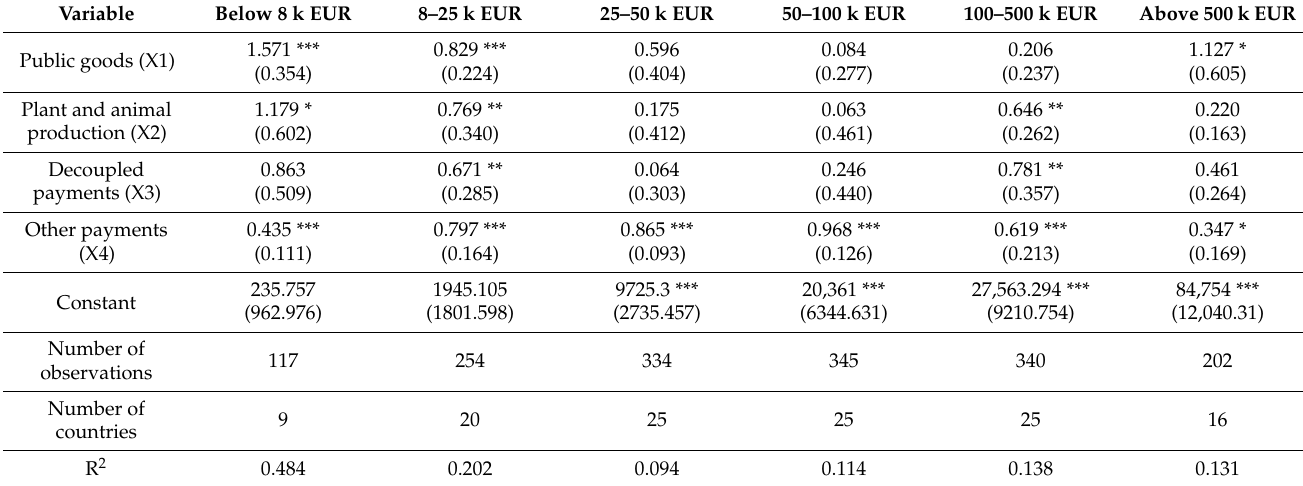
Table 2. Impact of CAP subsidies on the income of family farms in the European Union differing in the scale of production (years